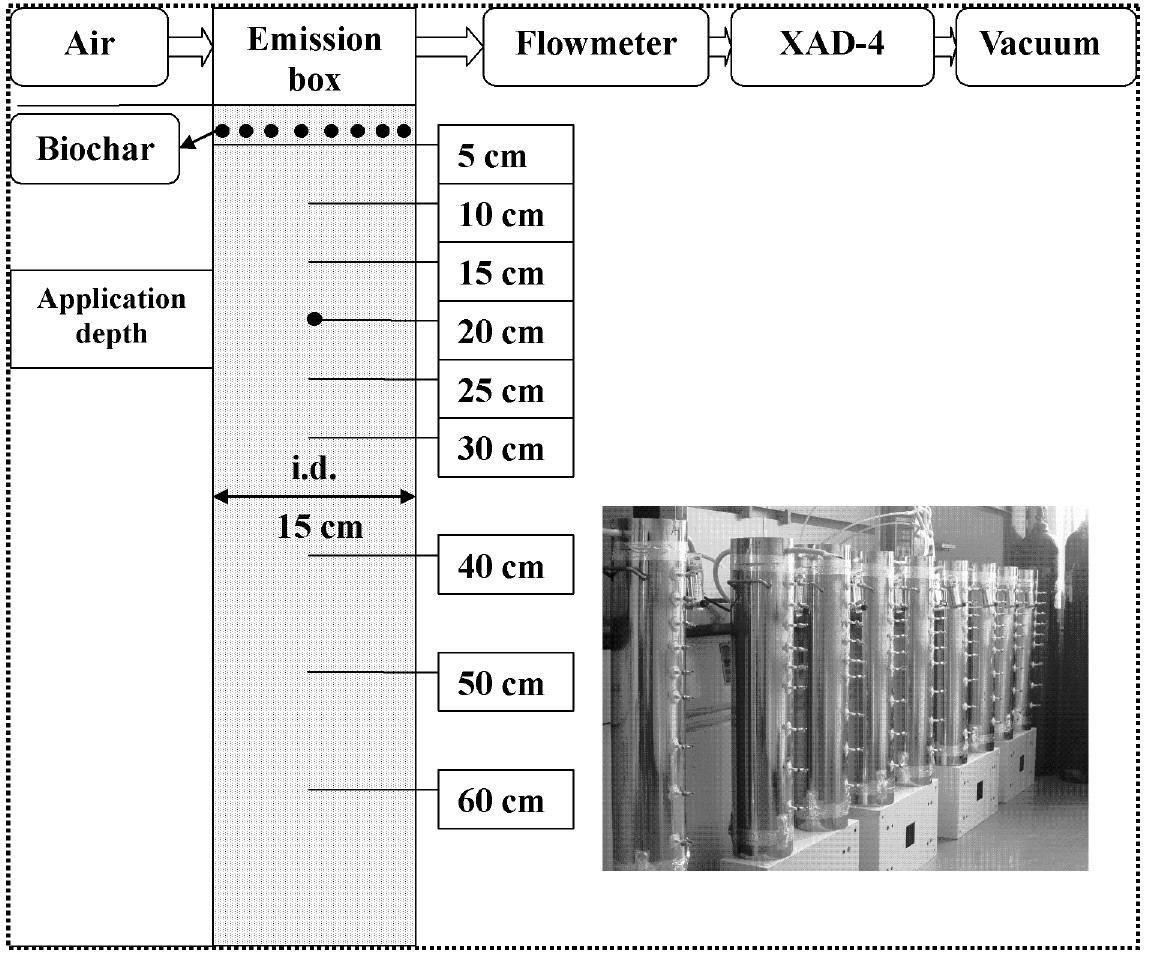
Fig 1. Schematic diagram of the soil